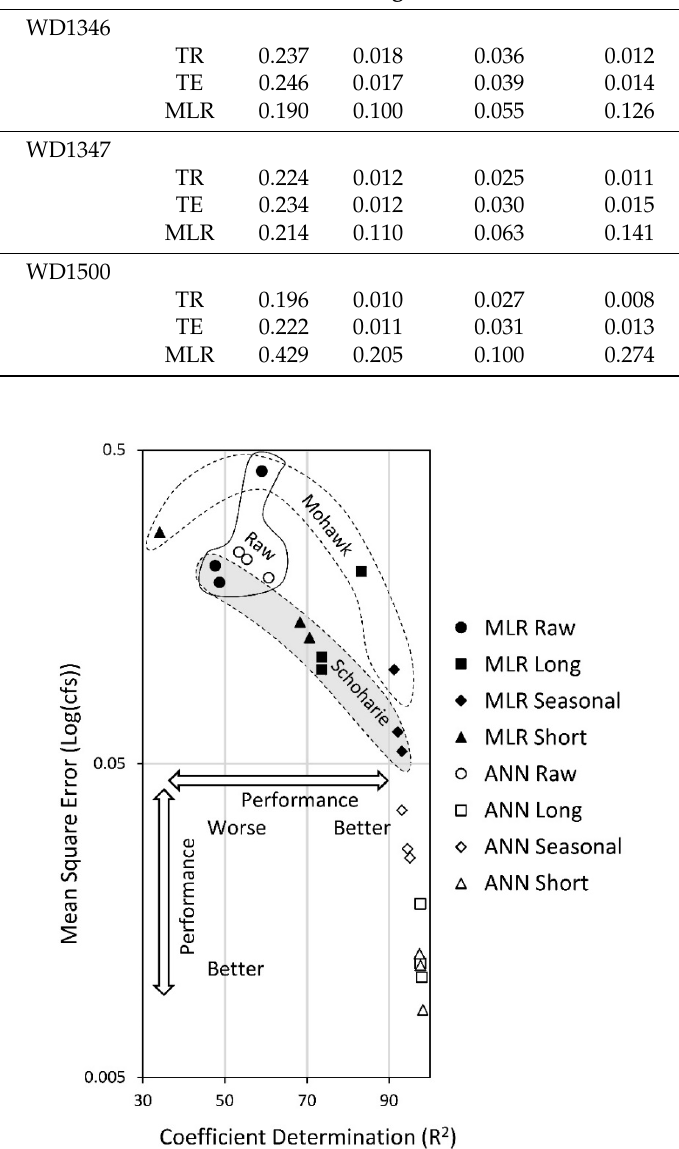
Table 3. The mean square of error (MSE) of the raw and decomposed data for the three water discharge stations. Training and testing data refer to the ANN (TR—training; TE—testing; MLR—multiple linear regression).